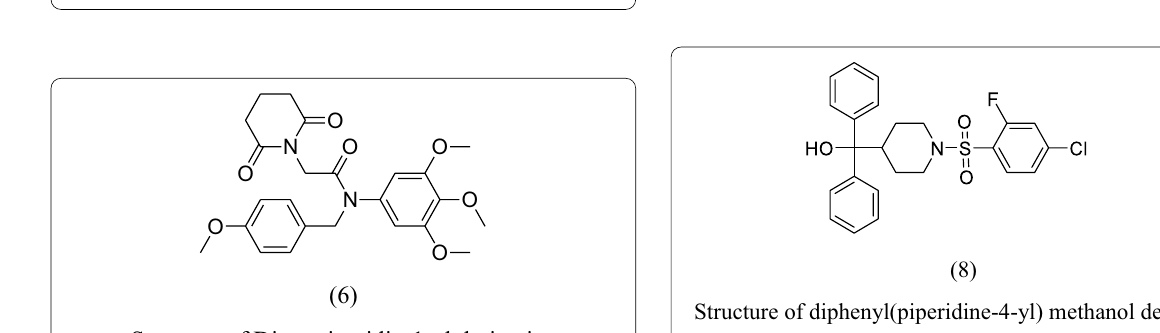
Fig. 16 Structure of diphenyl(piperidine‑4‑yl)methanol derivative